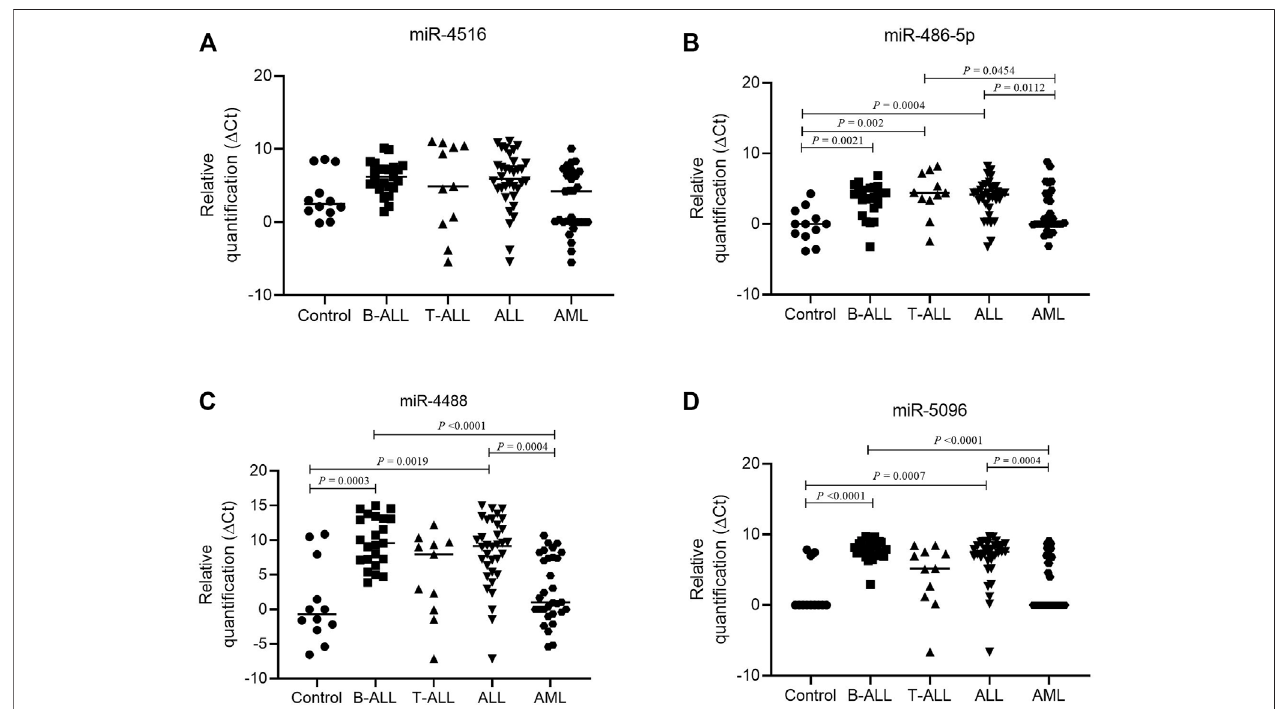
FIGURE 4 | Difference in miRNA expression in lymphoid and myeloid leukemia. (A) Relative expression of hsa-miR-4516 in control (circle, n = 12), B-ALL (square, n = 23), T-ALL (triangle, n = 11), ALL (inverted triangle, n = 34), and AML (hexagon, n = 31) groups; (B) relative expression of hsa-miR-486-5p in control (circle, n = 12), B-ALL (square, n = 23), T-ALL (triangle, n = 11), ALL (inverted triangle, n = 34), and AML (hexagon, n = 31) groups; (C) relative expression of hsa-miR-4488 in control (circle, n =12),B-ALL(square, n =23),T-ALL(triangle, n =11),ALL(invertedtriangle, n =34),andAML(hexagon, n =31)groups;and (D) relativeexpressionofhsa- miR-5096 in control (circle, n = 12), B-ALL (square, n = 23), T-ALL (triangle, n = 11), ALL (inverted triangle, n = 34), and AML (hexagon, n = 31) groups. For comparing three or more groups, the Kruskal – Wallis test was used followed by Dunn ’ s multiple comparison for two groups. Note: For delta Ct, the higher the values, the lower the miRNA